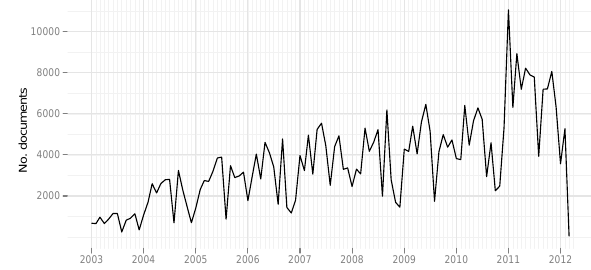
Figure 1. Monthly volume of public statements gathered in our